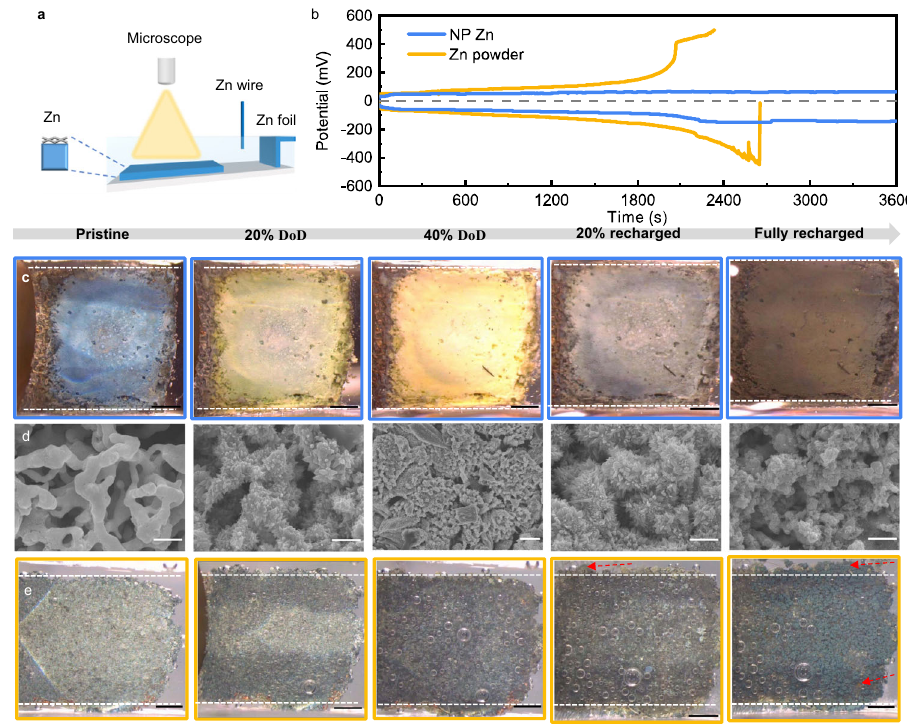
Fig. 3 Electrochemical and morphological investigations of the two different zinc metal electrodes. a A schematic of the three-electrode cell for the in situ optical microscopy. b Galvanostatic curves of the NP Zn and the Zn powder electrodes during discharging and charging at 20 mA/cm 2 . c Photographic pictures of the NP Zn anode captured at fi ve different stages: pristine, 20% discharged, 40% discharged, 20% recharged, and fully recharged, from left to right respectively. The states are estimated based on the theoretical capacities of the electrode. The white dashed lines, whose distance stays the same for all fi ve photographic pictures, correspond to the approximate boundaries of the pristine electrode. d SEM of the NP Zn anode harvested from the cell at the same states as the photographic pictures in c . e Photographic pictures of the Zn powder anode captured at nominally the same states as the NP Zn anode in c , where the red arrows highlight locations of morphology changes and the exposure of the Cu substrate. The scale bars are 1 mm in the photos and 1 µ m in the SEM images.